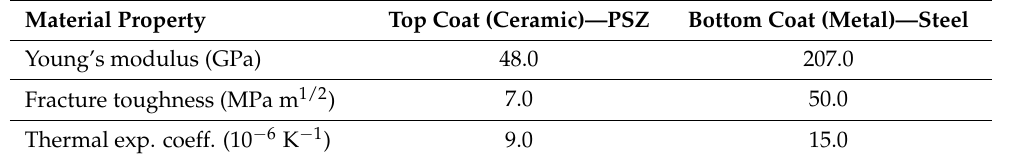
Table 1. Material parameters. Material